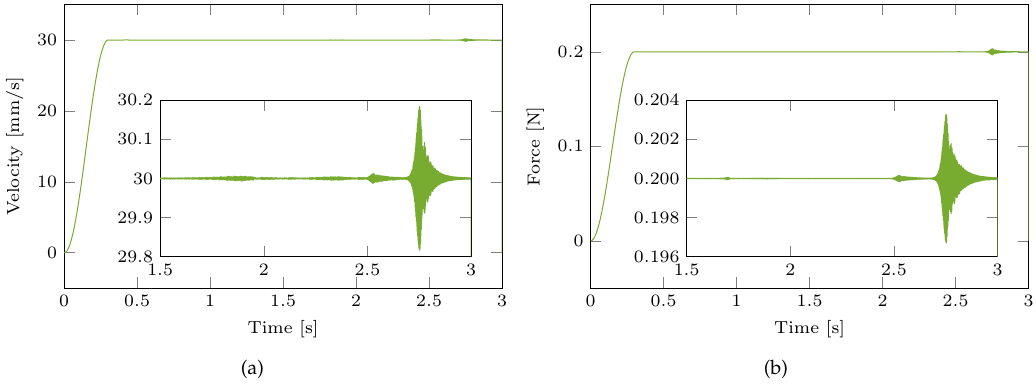
Figure 10. Relative velocity ( a ) and normal contact force ( b ) for the Subs-c